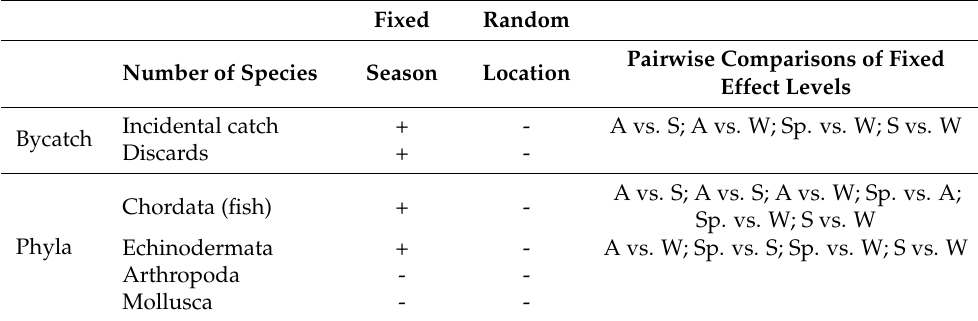
Table 3. Summary of the linear mixed model effects in the number of species, with season (fixed factor) and location (random factor) as predictors.